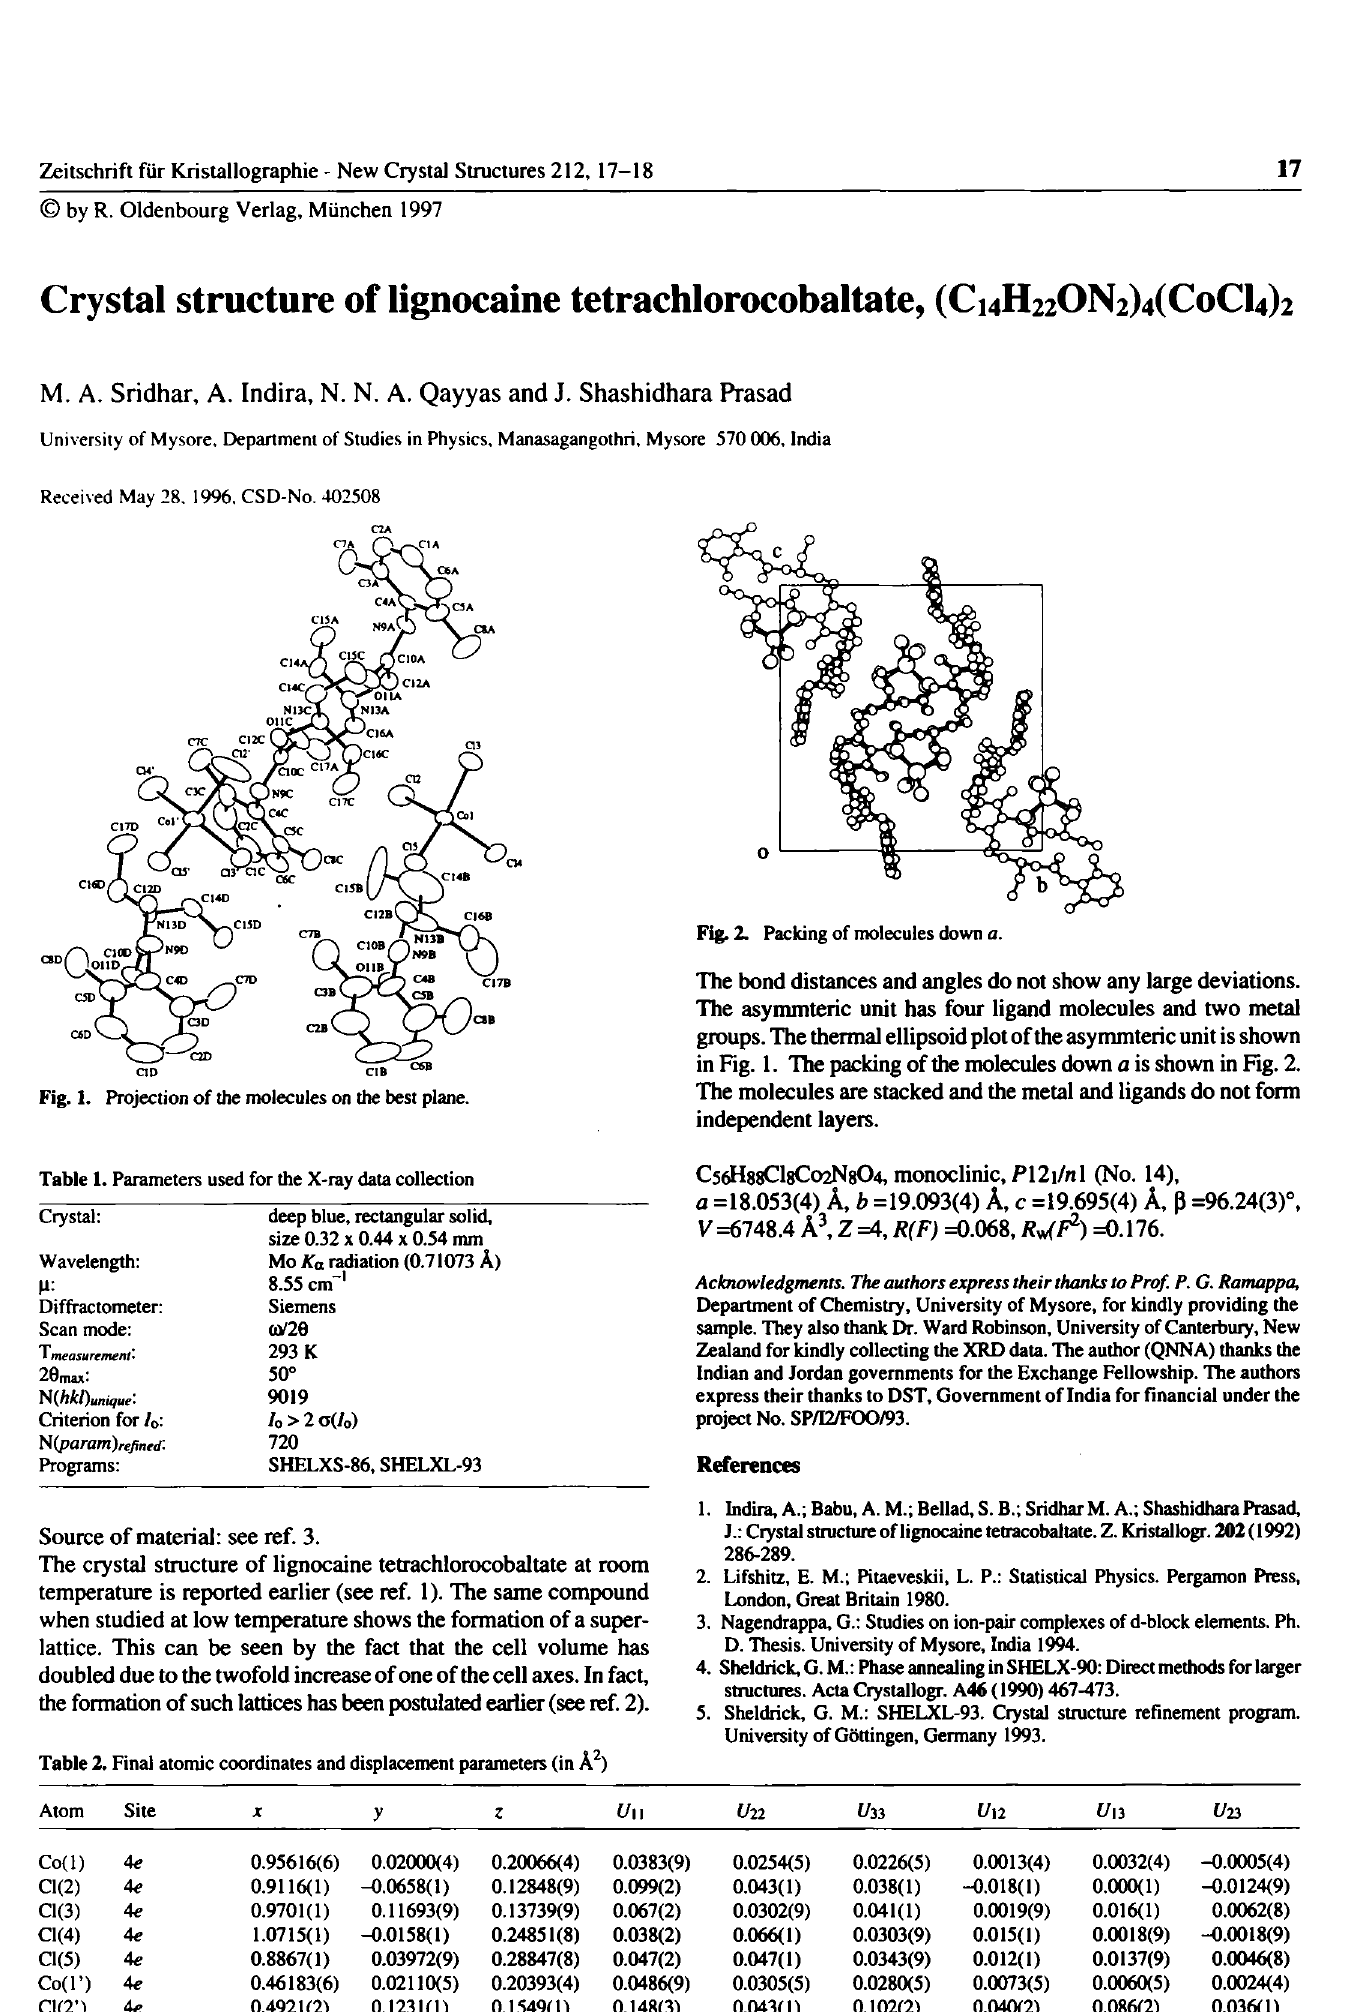
Table 1. Parameters used for the X-ray data collection Crystal: